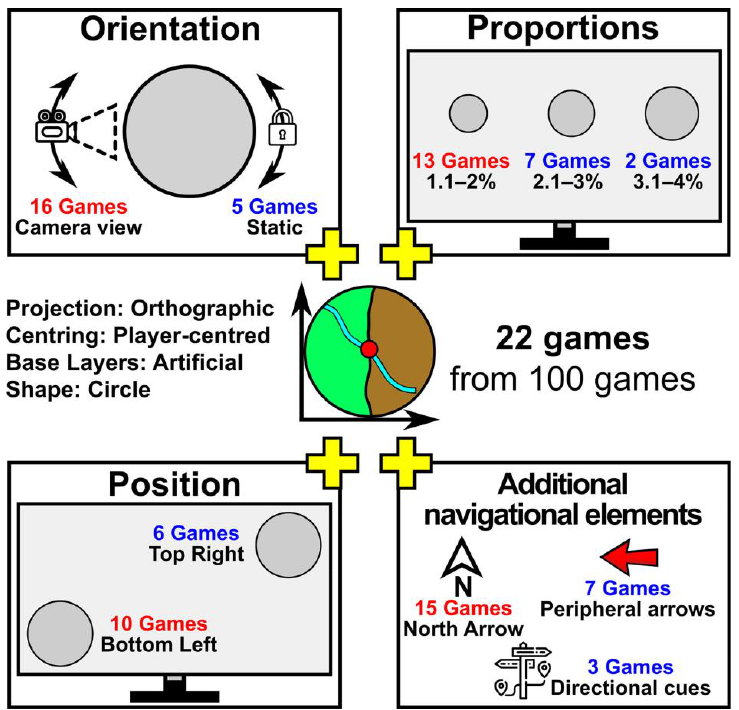
Figure 5. Grouping of the most popular and preferred parameters of the mini-map features: projec- tion, centring, base layers and shape with separate addition of other popular attributes or parameters from four other features (see Figure 3).